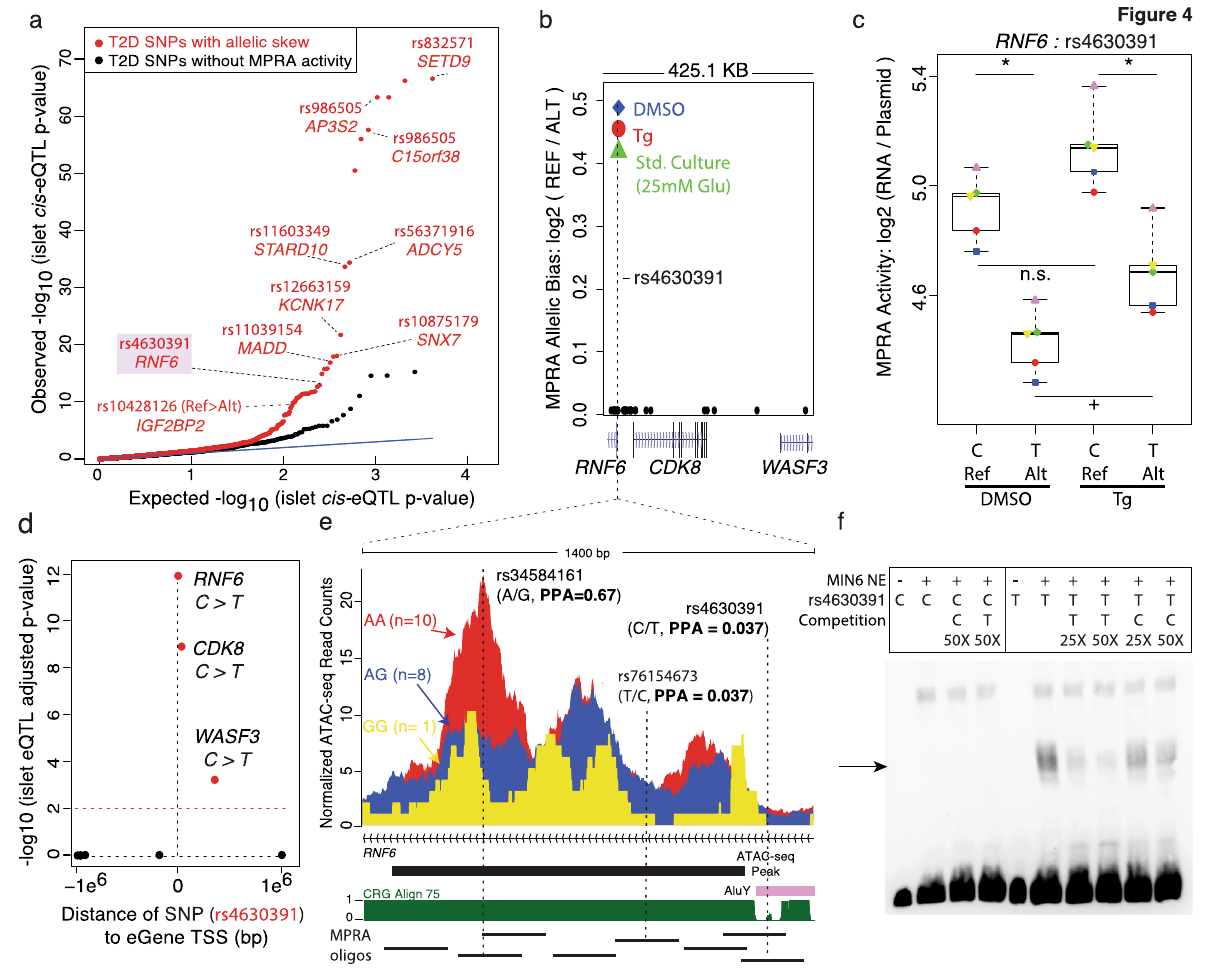
Fig. 4 MPRA identi fi es putative T2D causal SNPs altering islet expression (eQTL) and chromatin accessibility (caQTL). a Quantile-quantile plot of observed (y-axis) vs. expected ( x -axis) islet eQTL p-values from the InsPIRE Consortium for T2D SNPs, categorized based on whether ≥ 1 SNPs in LD had allelic skew (red dots), or 0 SNPs in LD had signi fi cant MPRA activity (black dots). b Plot of genome location of 27 SNPs in high LD ( r 2 ≥ 0.8) with the